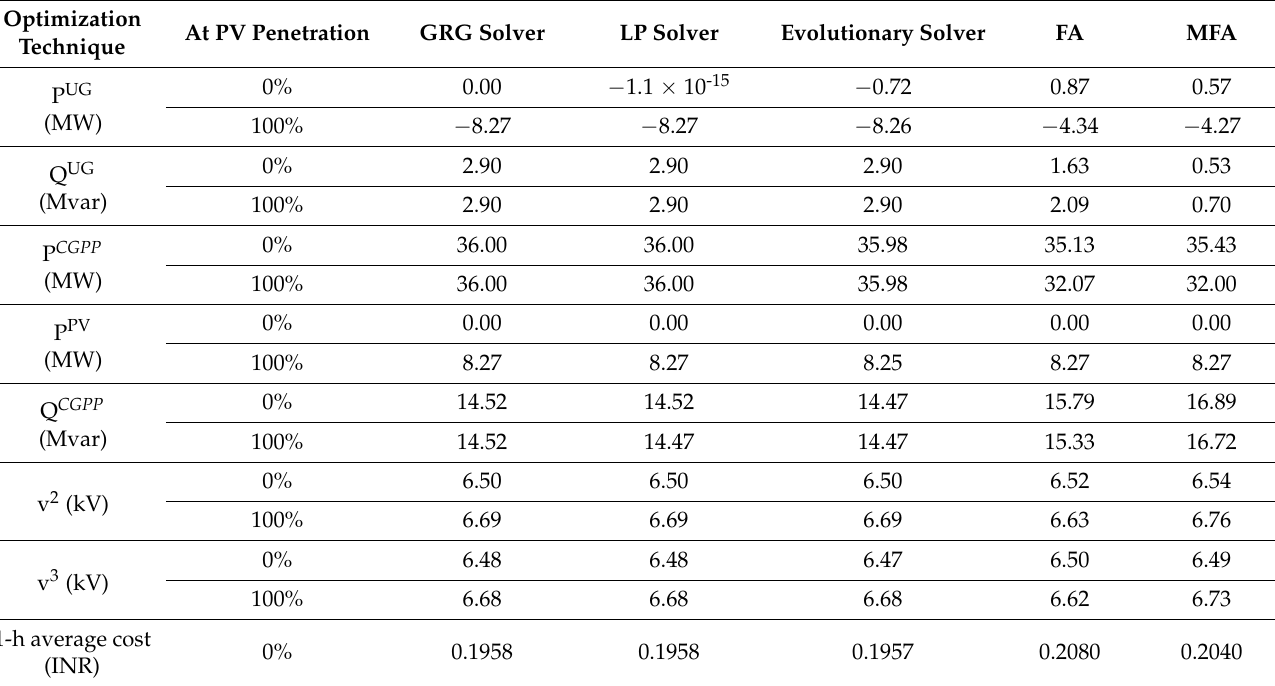
Table 9. Power flow results of all optimization techniques.